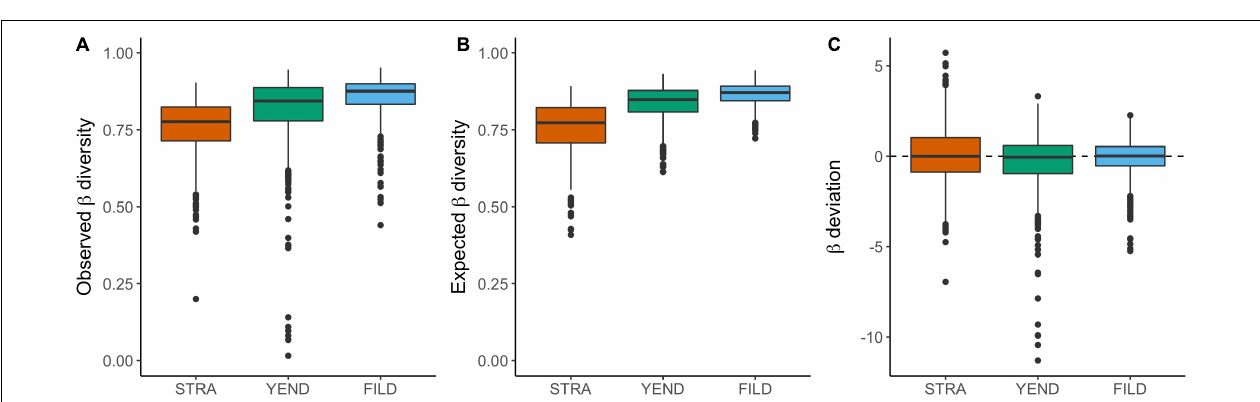
FIGURE 3 | Species richness observed at the scales of site ( A , alpha diversity) and locality ( B , gamma diversity estimated as asymptotic Jacknife species richness).